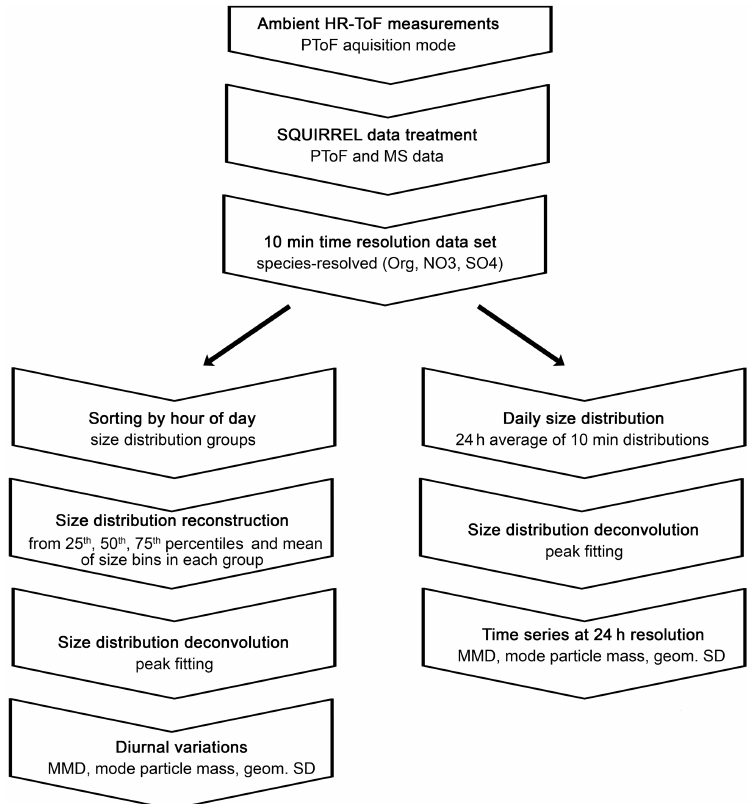
Figure 1. Flow chart of main data acquisition, data treatment, and data analysis